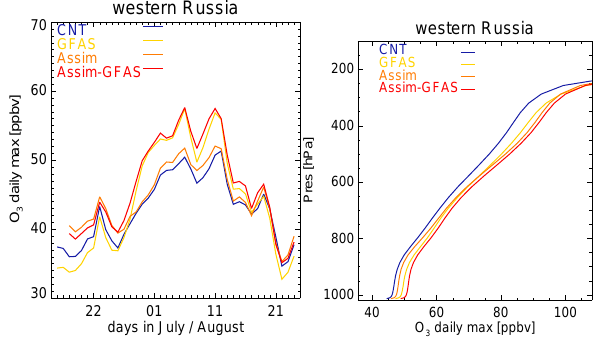
Fig. 11. (left) Maximum area-average surface O 3 concentrations over western Russia for the four model settings, hindcast D+0. (right) corresponding time averaged profile of ozone daily maxi- mum concentrations between 20 July and 15